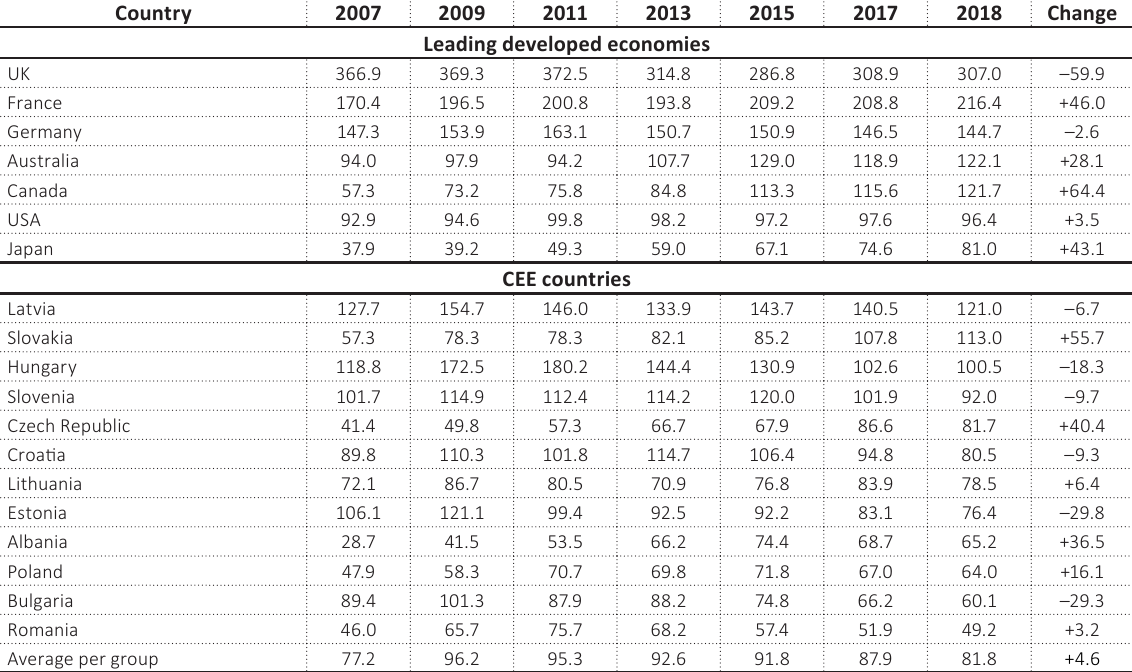
Table 3. External debt to GDP ratio in selected developed economies and CEE countries, 2007–2018,